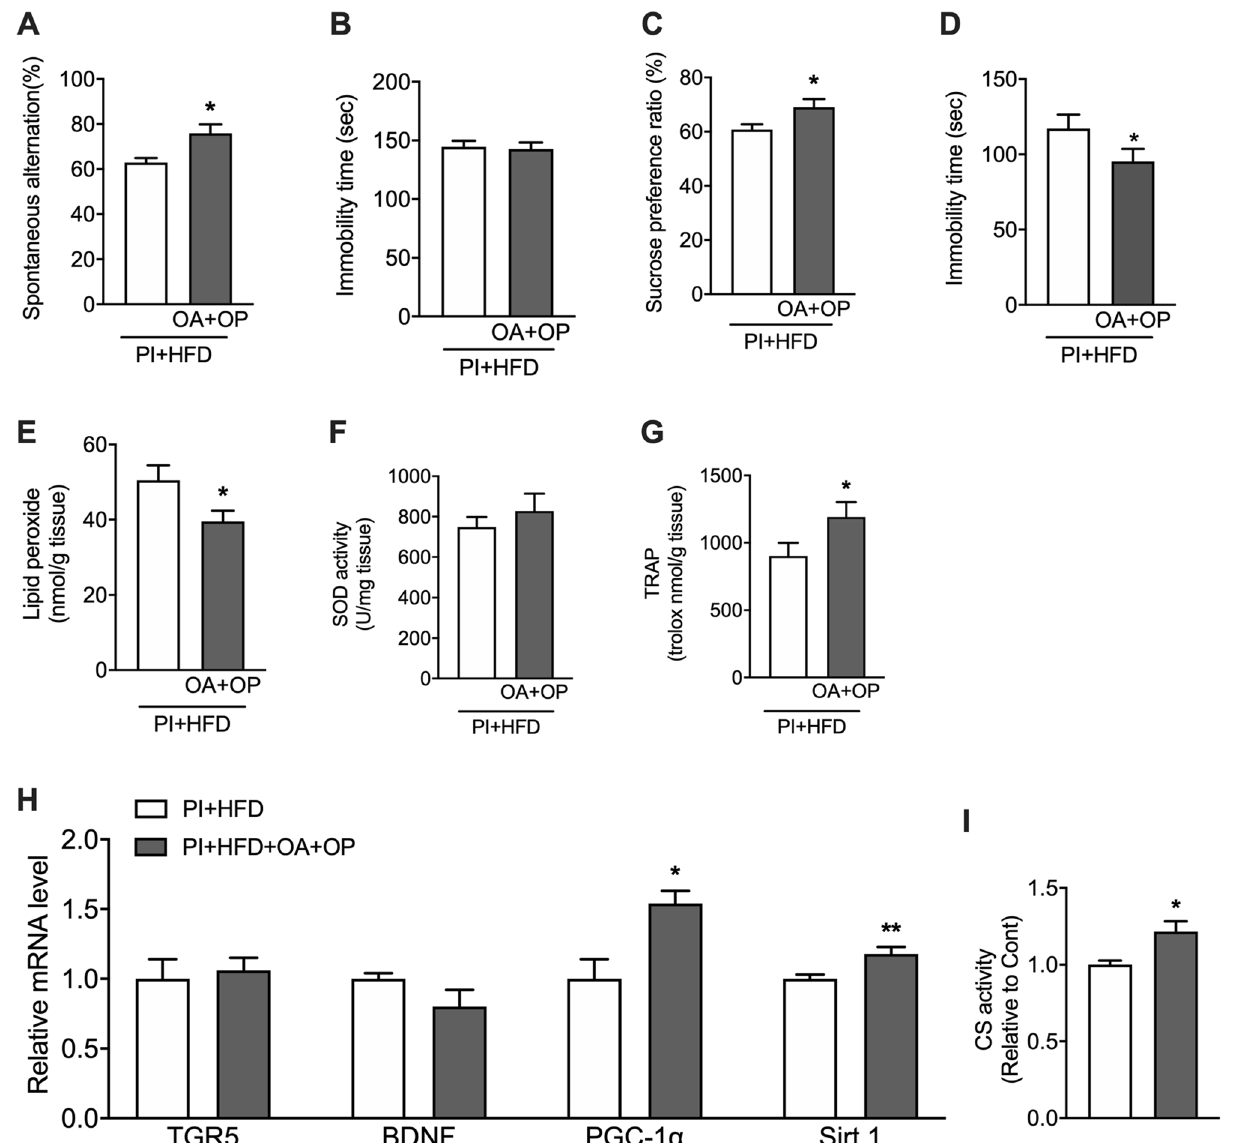
Figure 4. Combined administration of oleanolic acid (OA) and oleuropein (OP) prevented behavioral changes induced by inactivity and a high-fat diet (HFD). ( A ) Accuracy rate in the Y-maze test, ( B ) immobility time in the contextual fear conditioning test, ( C ) sucrose preference ratio in the sucrose preference test, ( D ) immobility time in the forced swim test, ( E ) hippocampal lipid peroxide content, ( F ) hippocampal SOD activity, ( G ) hippocampal TRAP level, ( H ) mRNA expression levels of TGR5 , BDNF , PGC-1α , and Sirt1 in the hippocampus by real-time polymerase chain reaction, ( I ) CS activity. *p < 0.05 vs. PI + HFD as determined by unpaired, two- tailed t